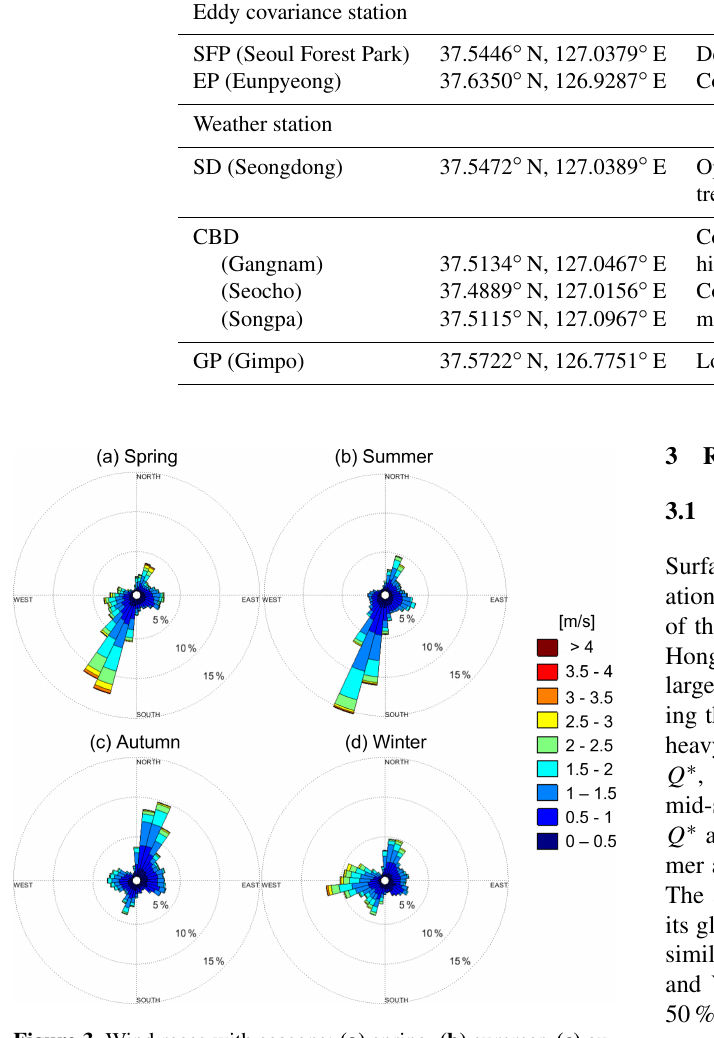
Figure 3. Wind roses with seasons: (a) spring, (b) summer, (c) au- tumn, and (d)